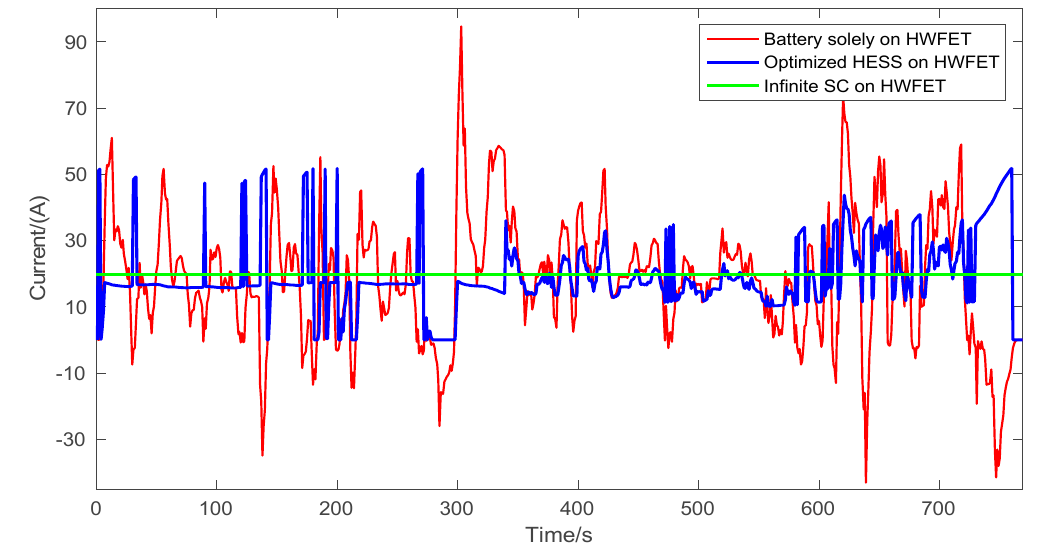
Figure 13. Battery current in different scenarios.